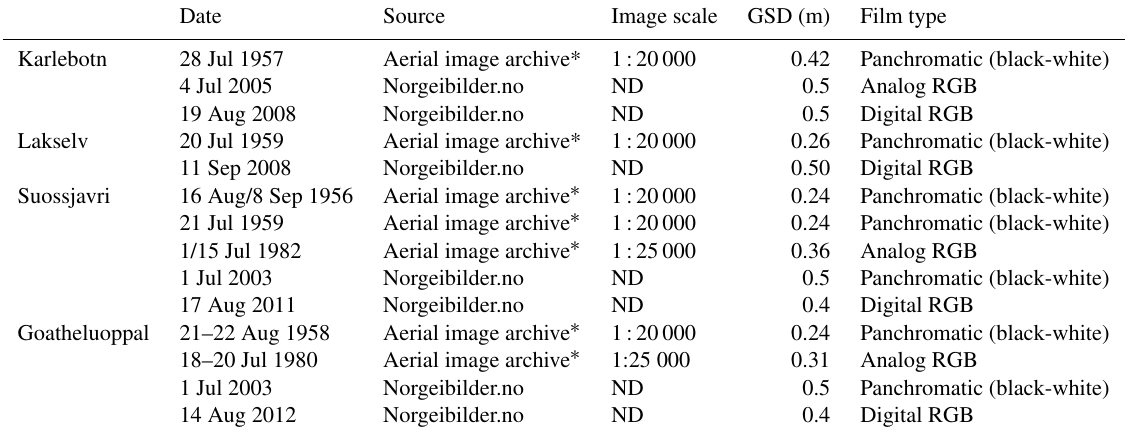
Table 1. Key information about the aerial images utilized in this study. The images are either gathered from Norgeibilder (2015) or ordered directly from the Norwegian Mapping Authority, Norway, through an aerial image archive (Kartverket, 2015a). GSD is ground sample distance, i.e. the distance between the centres of adjacent pixels measured on the ground. Date Source Image scale GSD (m) Karlebotn